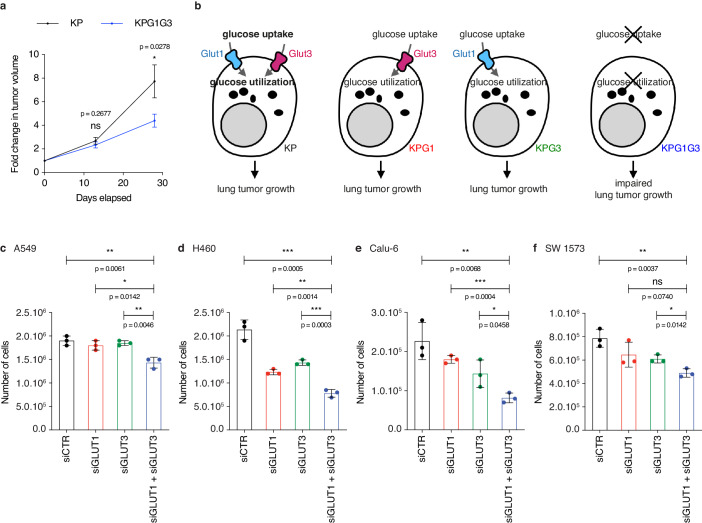
Dual knockdown of GLUT1 and GLUT3 most strongly reduces human non-small cell lung cancer cell viability in vitro, corroborating the in vivo data.(a) Graph with mean ± s.e.m. shows the fold changes of KP and KPG1G3 tumor volumes (n = 32 and 20, respectively) monitored during 28 days by X-rays micro-computed tomography (μCT), starting at 16 weeks and 6 days post-tumor initiation with tumor volumes set to 1. ns: not significant by Mann-Whitney test; *: p < 0.05 by Mann-Whitney test. (b) Model illustrating the different studied scenarios. (c-f) Dot plots with mean ± s.d. exhibit the average number of cells 72 hours after transfection with siCTR, siGLUT1, siGLUT3, or siGLUT1 + siGLUT3 in (c) A549, (d) H460, (e) Calu-6, and (f) SW 1573 cells. Each condition was performed in 3 technical replicates. ns: not significant by t-test; *: p < 0.05 by t-test; **: p < 0.01 by t-test; ***: p < 0.001 by t-test.Figure 4—figure supplement 3—source data 1.Source files for tumor growth of KP and KPG1G3 mice.